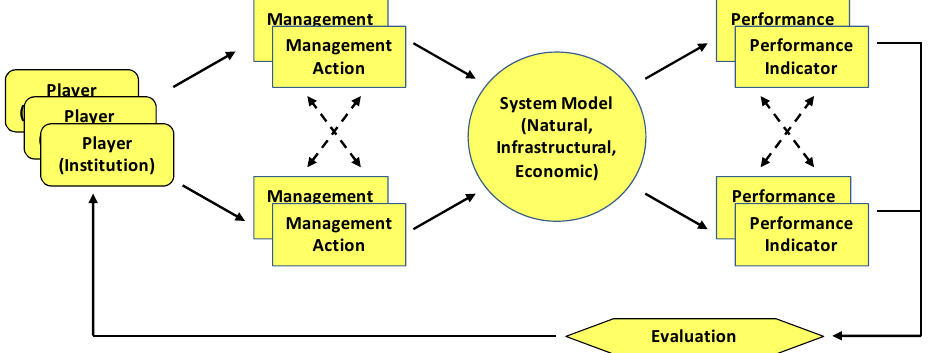
Figure 1: Typical structure of a water management system simulation game Fig. 1. Typical structure of a water management system simulation